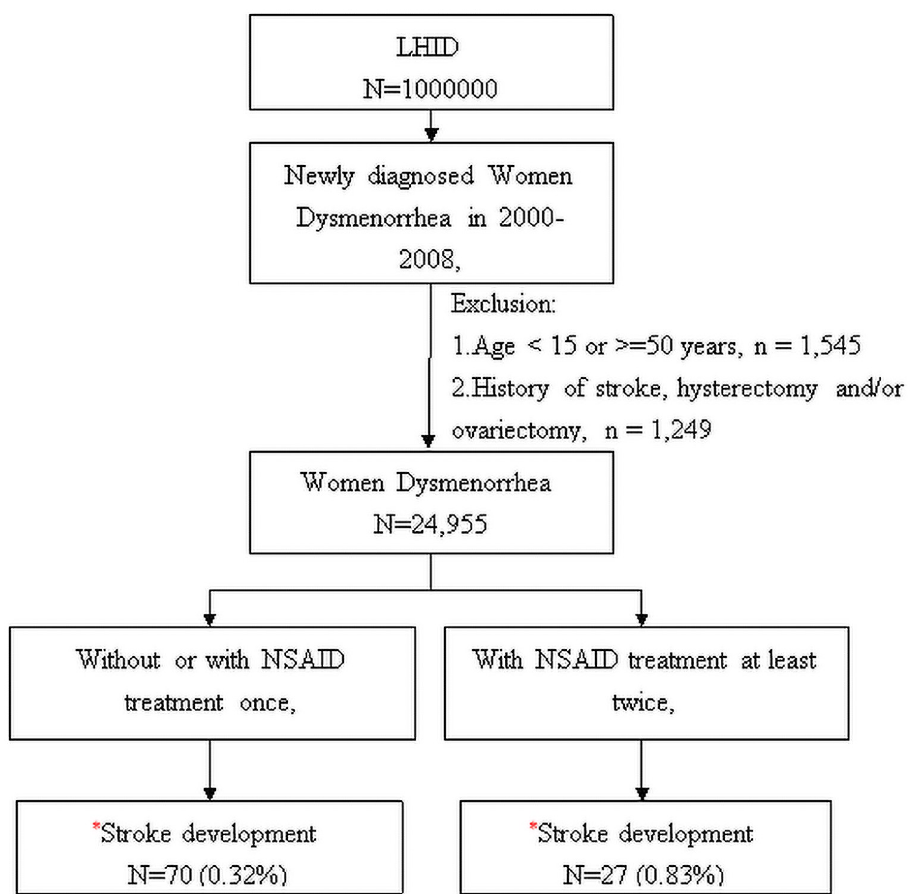
Fig 1. Flowchart showing the process of sample selection. � p <